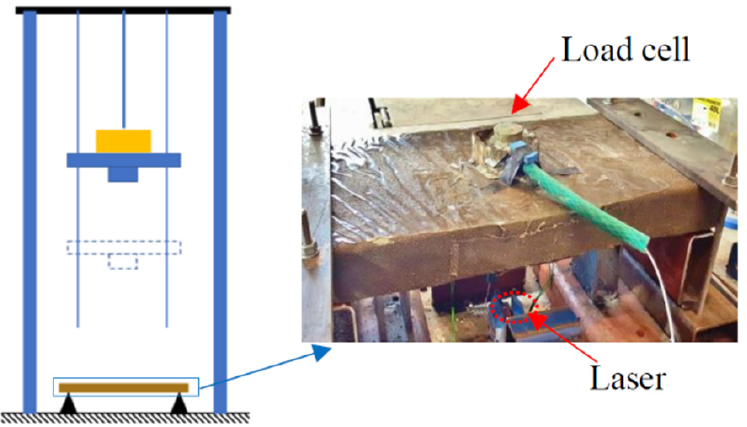
Figure 6. Sketch of impact machine and specimen set-up.